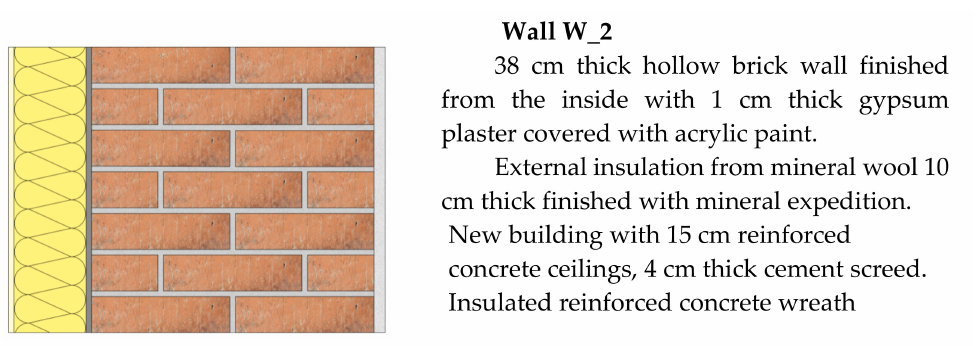
Figure 8. Description of the wall system solution for variant W_1.